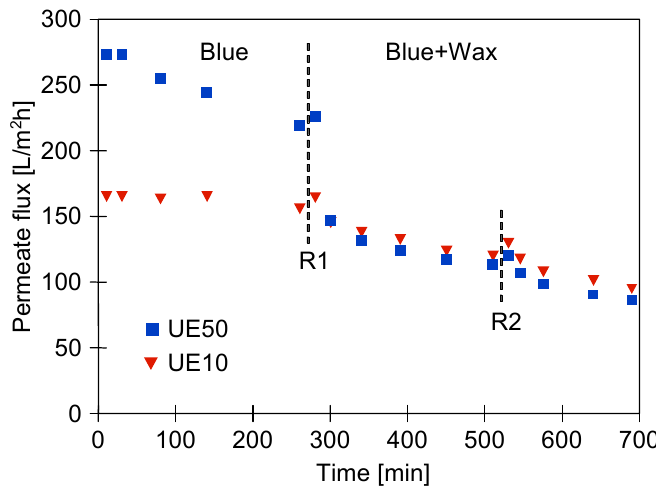
Figure 5. Changes in the permeate flux during UF of blue and blue + wax solutions. R1, R2—modules rinsed with water. TMP = 0.2 MPa, feed flow velocity: 0.6 m/s.